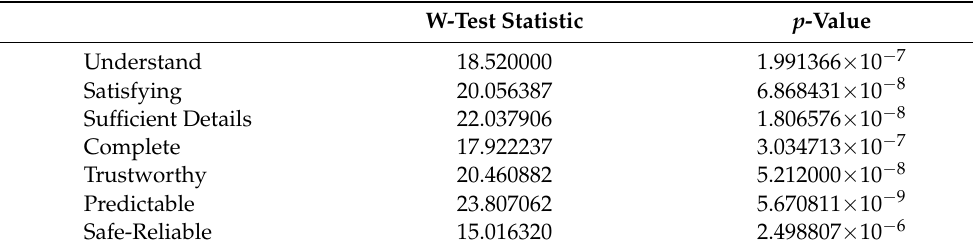
Table A8. Levene’s test results for “Why not”